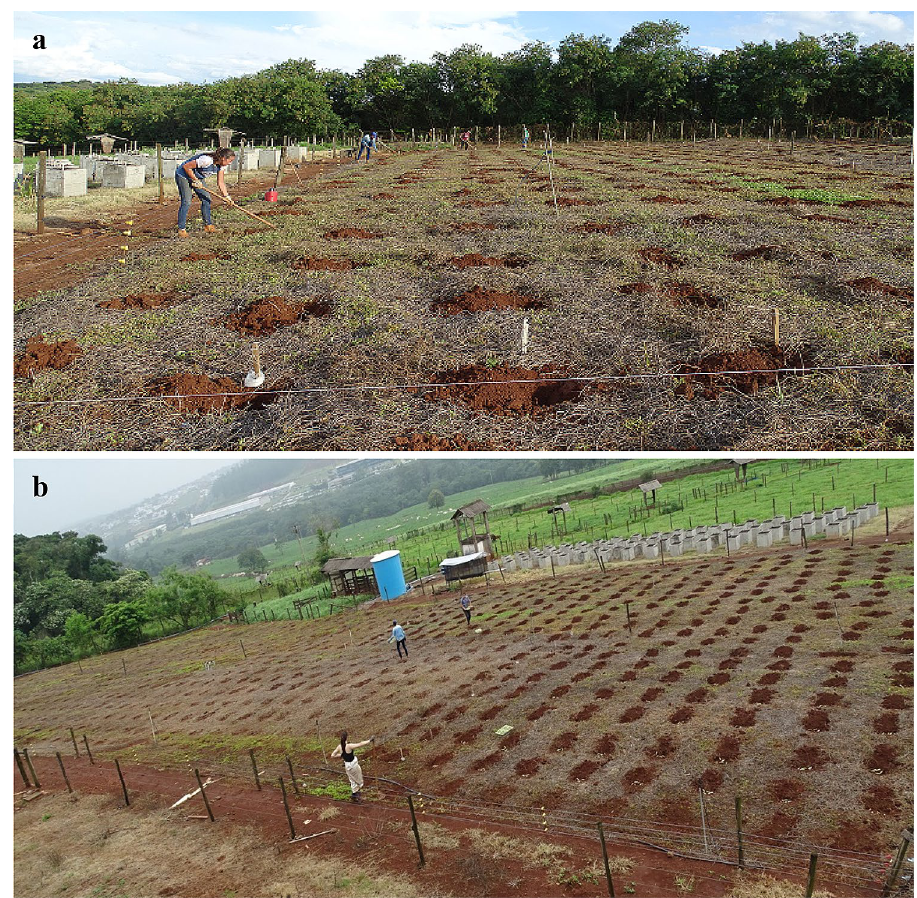
Figure 8. General view of the experimental site during the establishment phase showing the layout and distribution of elephant grass plants on the area: ( a ) Pit opening and ( b ) planting of the stem